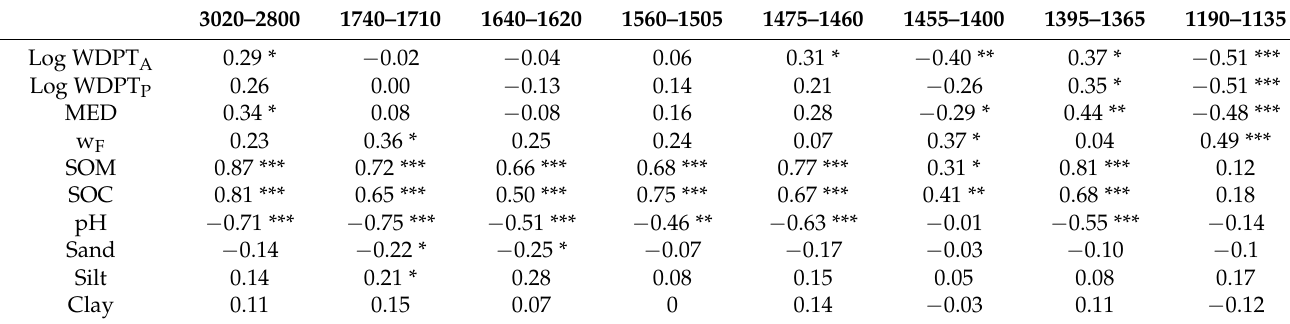
Table 3. Correlations (r values and corresponding p < 0.05 *, 0.01 **, and 0.001 *** significance levels) between FTIR peak areas integrated in eight frequency intervals (cm − 1 ), SWR data (WDPT, MED), and basic soil